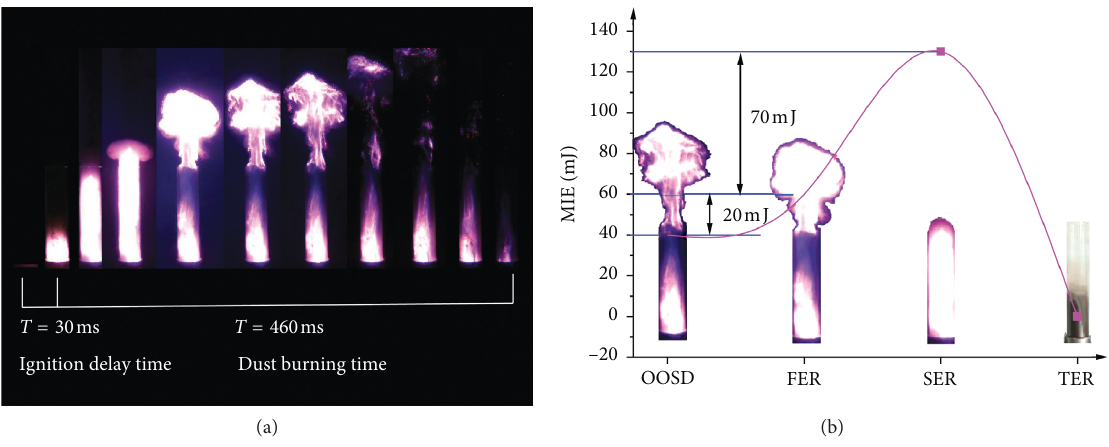
Figure 6: The experimental process of the explosion of oil shale dust and an analysis of the MIE: (a) the experimental process of the measurement of the MIE of oil shale dust and (b) the variation curve of the MIE of oil shale dust in the multiexplosion process.